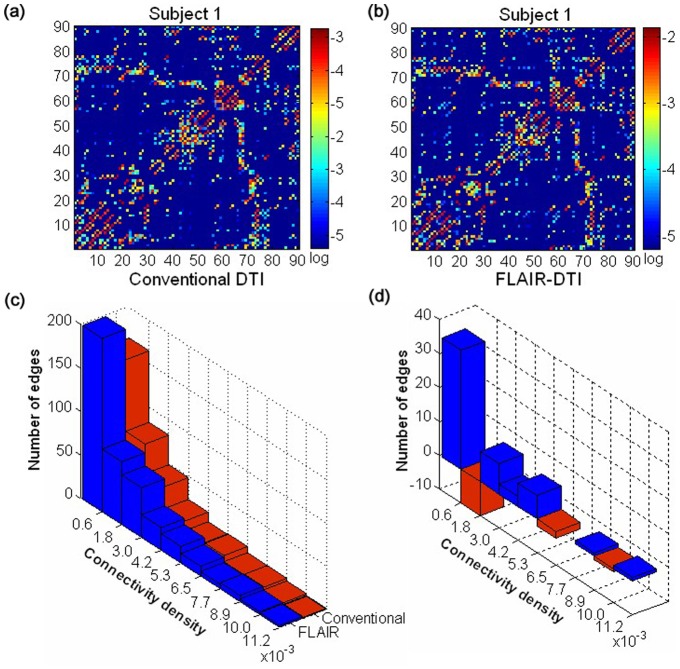
Variability in the connectivity patterns of the anatomical networks corresponding to the conventional DTI datasets and the FLAIR-DTI datasets.(a) The weighted connectivity matrix constructed from the conventional DTI data for a single subject. The weighted connectivity matrix is displayed using a logarithmic color map. (b) Same as (a) but showing the FLAIR-DTI data from a single subject. (c) Histograms of the edges derived from the backbone anatomical networks corresponding to the two types of DTI datasets. (d) Difference between the two types of DTI-based networks in the number of edges vs. connectivity density. Bars in blue (red) indicate the number of edges in the anatomical networks of the FLAIR-DTI datasets that were higher (lower) than those of the conventional DTI datasets.